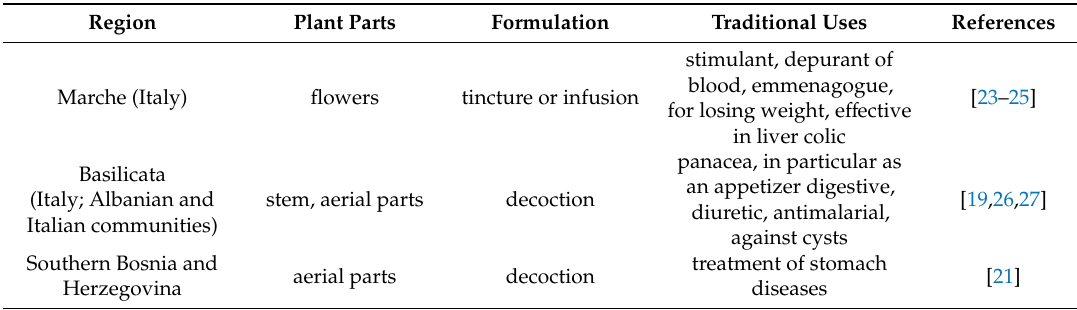
Table 1. Traditional medicinal uses of Marrubium incanum .